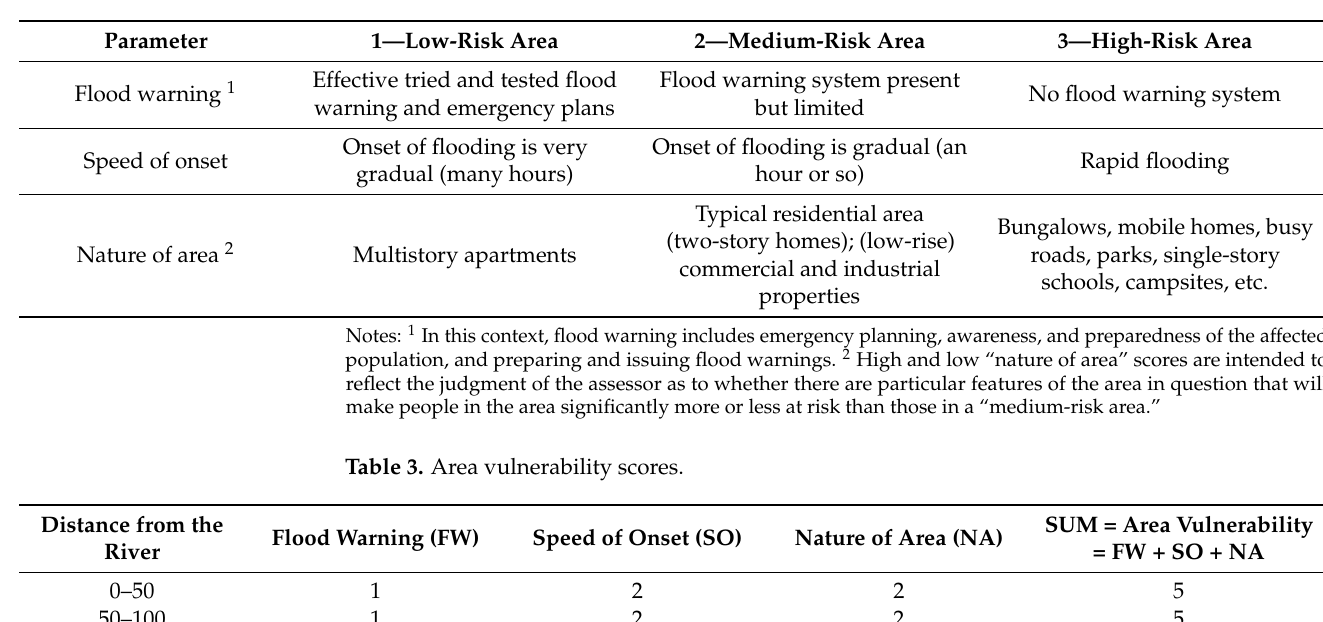
Table 2. Area vulnerability (AV) [31].